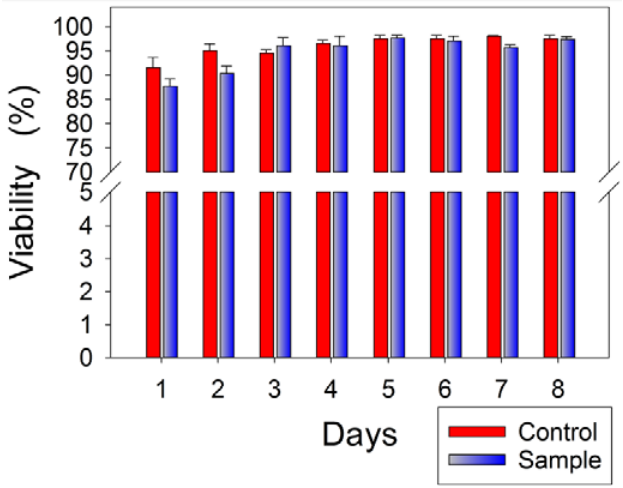
Figure 5. Cytotoxicity assessment of K562 cells on the multilayer nanofiber-hydrogel meshes. The cells grown in regular 24-well plates were setup as the control, and a five-layer specimen mesh as the experimental